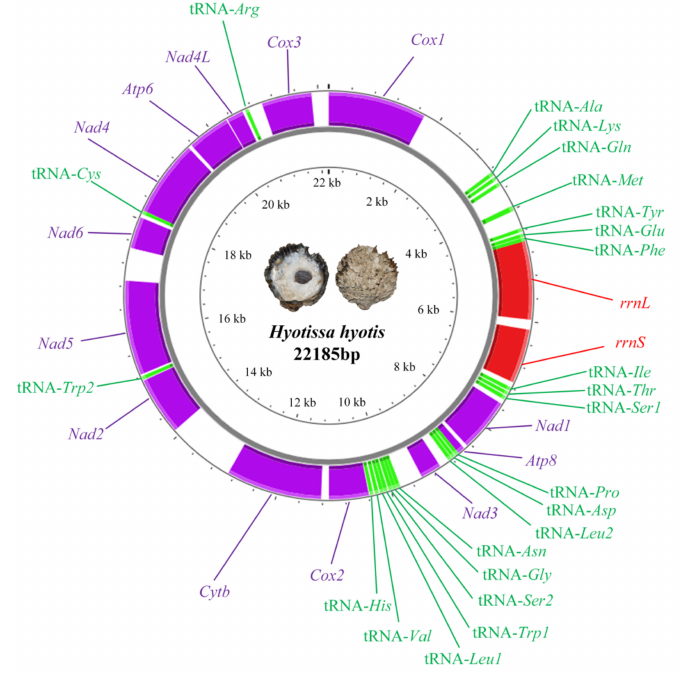
Figure 1. Mitochondrial genome map of Hyotissa hyotis . Table 2. Gene annotations of the mtDNA of Hyotissa hyotis